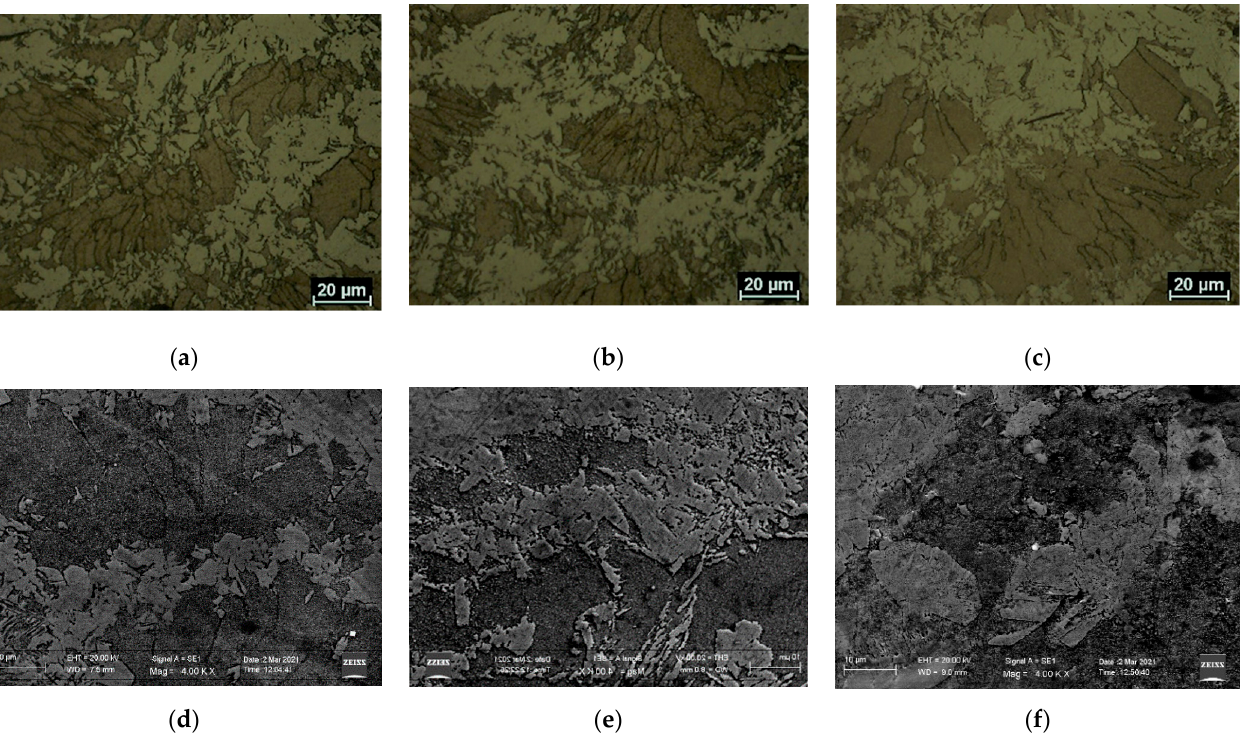
Figure 3. High magnification (1000×) optical ( a , b , c ) and scanning electron microscope (SEM) (4000×) ( d , e , f ) micrographs of the D 0 specimen in ( a , d ) D d1 in ( b , e ) and D c1 in ( c , f ) showing elongated grains inside the melting pool ( a , b , c ) with some traces of boundary phase distributed also in the inner of the melting pool ( c , d , e